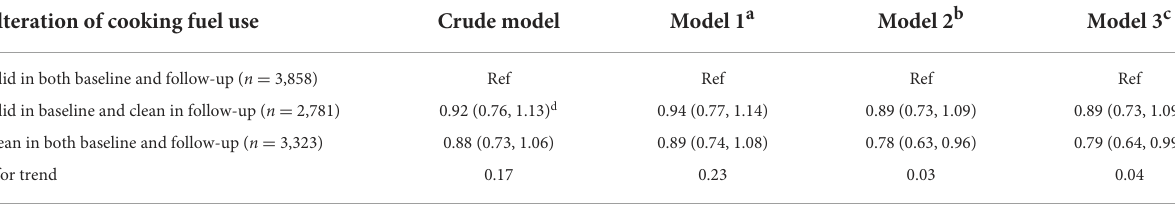
TABLE 4 Associations between alteration of household solid fuel use for cooking and stroke. Alteration of cooking fuel use